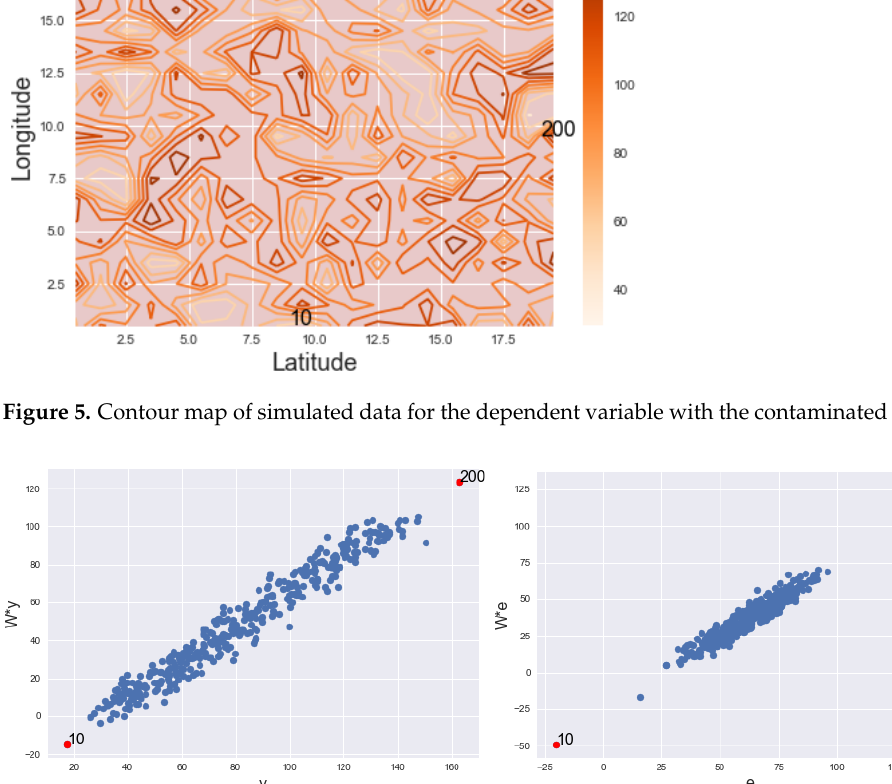
Figure 7. Index plot of ( a ) t 2